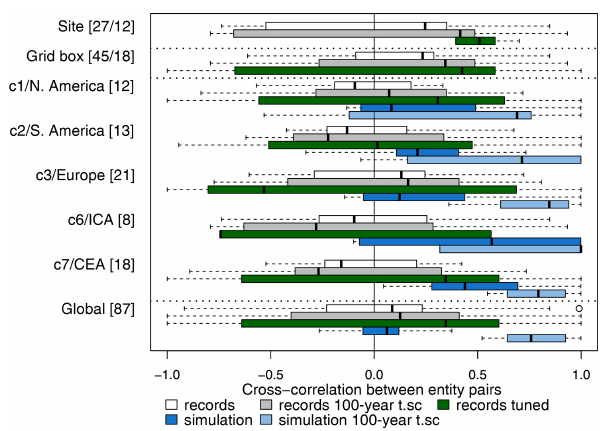
Figure 9. Cross-correlation on site, grid boxes, clusters and global scale for speleothem records and the locally interpolated model out- put for δ 18 O pw . The 12 (18) sites (grid boxes) contain more than one speleothem entity with a total of 27 (45). At each aggrega- tion level the correlation estimates between all entities is shown for δ 18 O speleo (white bars), and the down-sampled model output δ 18 O pw of LM1-3 at cave locations (blue bars). Different temporal scales (original resolution and 100-year timescale (t.sc)) are com- pared as well as the age-model ensemble that gives the highest ab- solute correlation (dark green bars). Clusters are indicated with the number of speleothem entities in brackets, where c4, c5, c8, and c9 are not included because they contain too few entities. c6/ICA is the India and Central Asia cluster, c7/CEA is the China and Eastern Asia